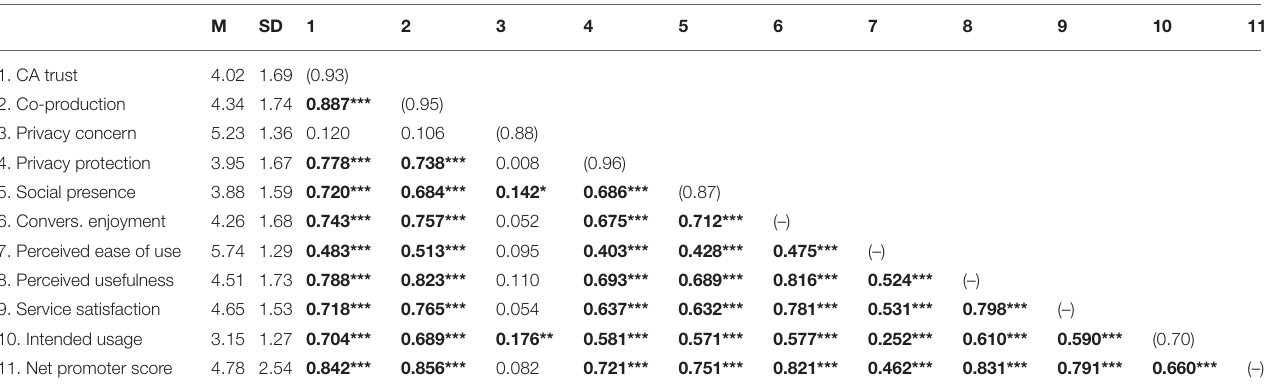
TABLE 2 | Pearson correlations of dependent